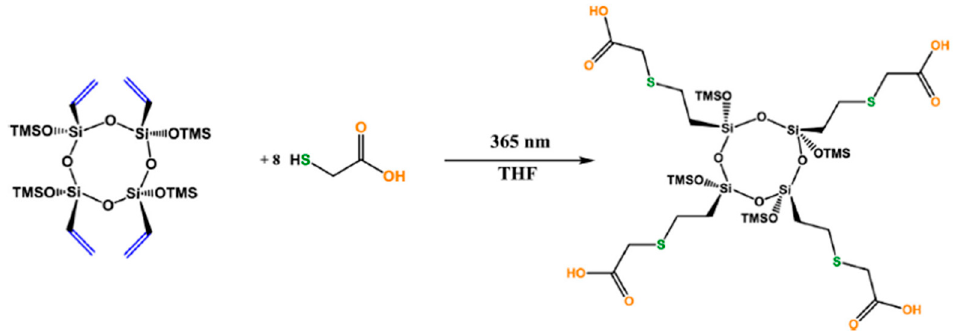
Figure 22. The reaction of all-cis-tetravinyl-tetrakis(trimethylsiloxy)cyclotetrasiloxane with thioglycolic acid. Reproduced with permission from Ref. [96]. Copyright (1997), with permission from Elsevier.